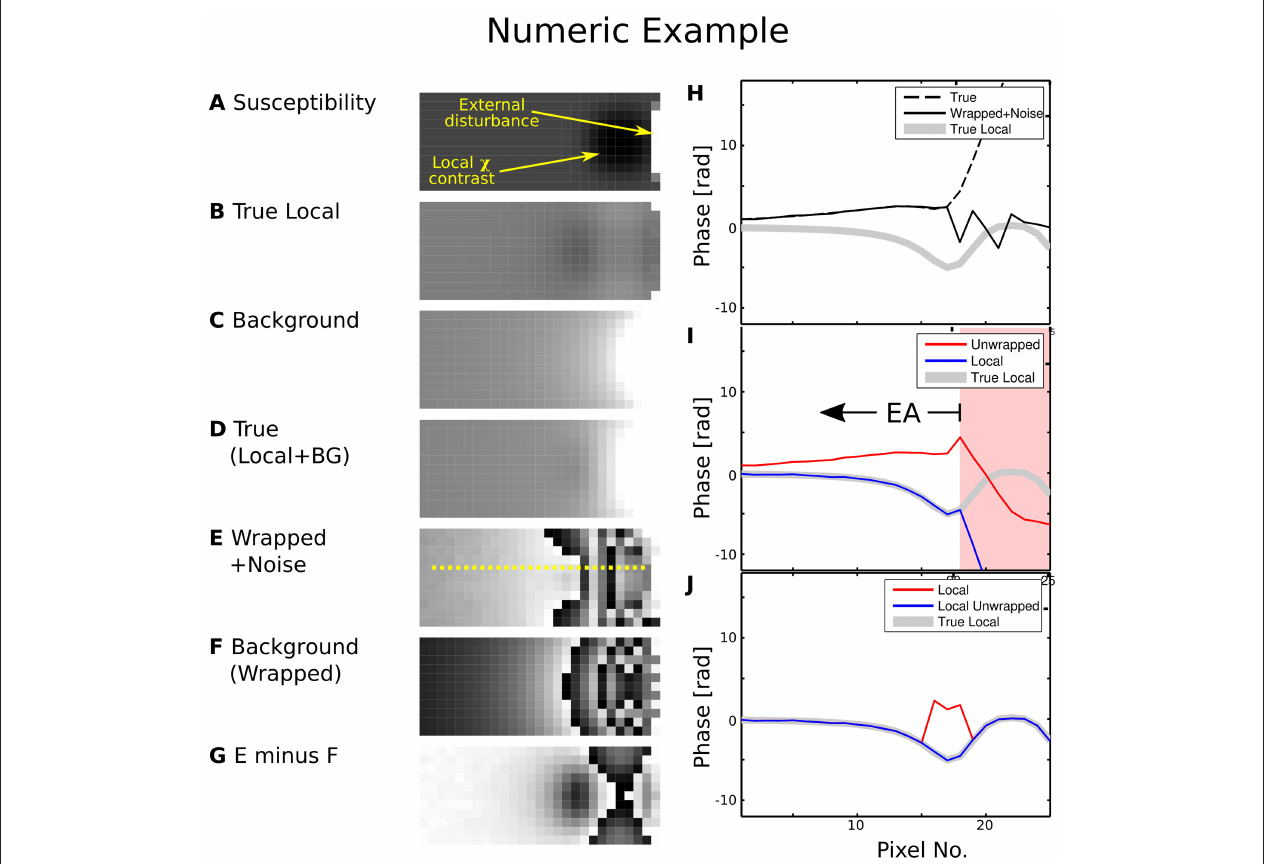
FIGURE 1 | Numeric phase data example. The left-hand side shows (A) a susceptibility map, (B) the local phase generated by the smooth susceptibility sphere from (A,C) background phase generated by the external disturbance, (D) True composed phase (B)+(C) , (E) “Measurement” simulated by wrapped phase (D) with noise contamination, (F) Wrapped true background phase (C,G) background phase (F) subtracted from measurement (E) . The yellow line cut indicated in (E) was processed in (I) and (J) . The right-hand side shows plots along the line cut for (H) true phase, wrapped phase with noise contamination and true local phase, (I) first unwrapped, then background-subtracted phase, (J) first background-corrected as in (G) , then unwrapped phase. Greyscale colour ranges are: (A) [ − 6, 15] ppm, (B–D) [ − 20, 20] rad, (E–G) [0, 2 π ] rad. Prior background phase removal (J) leads to a correct local phase estimation for pixels beyond no. 18, while first performing the unwrap does not [area with background shaded in red in (I) ]. For case (I) , the EA would have to be restricted to voxels left of no.